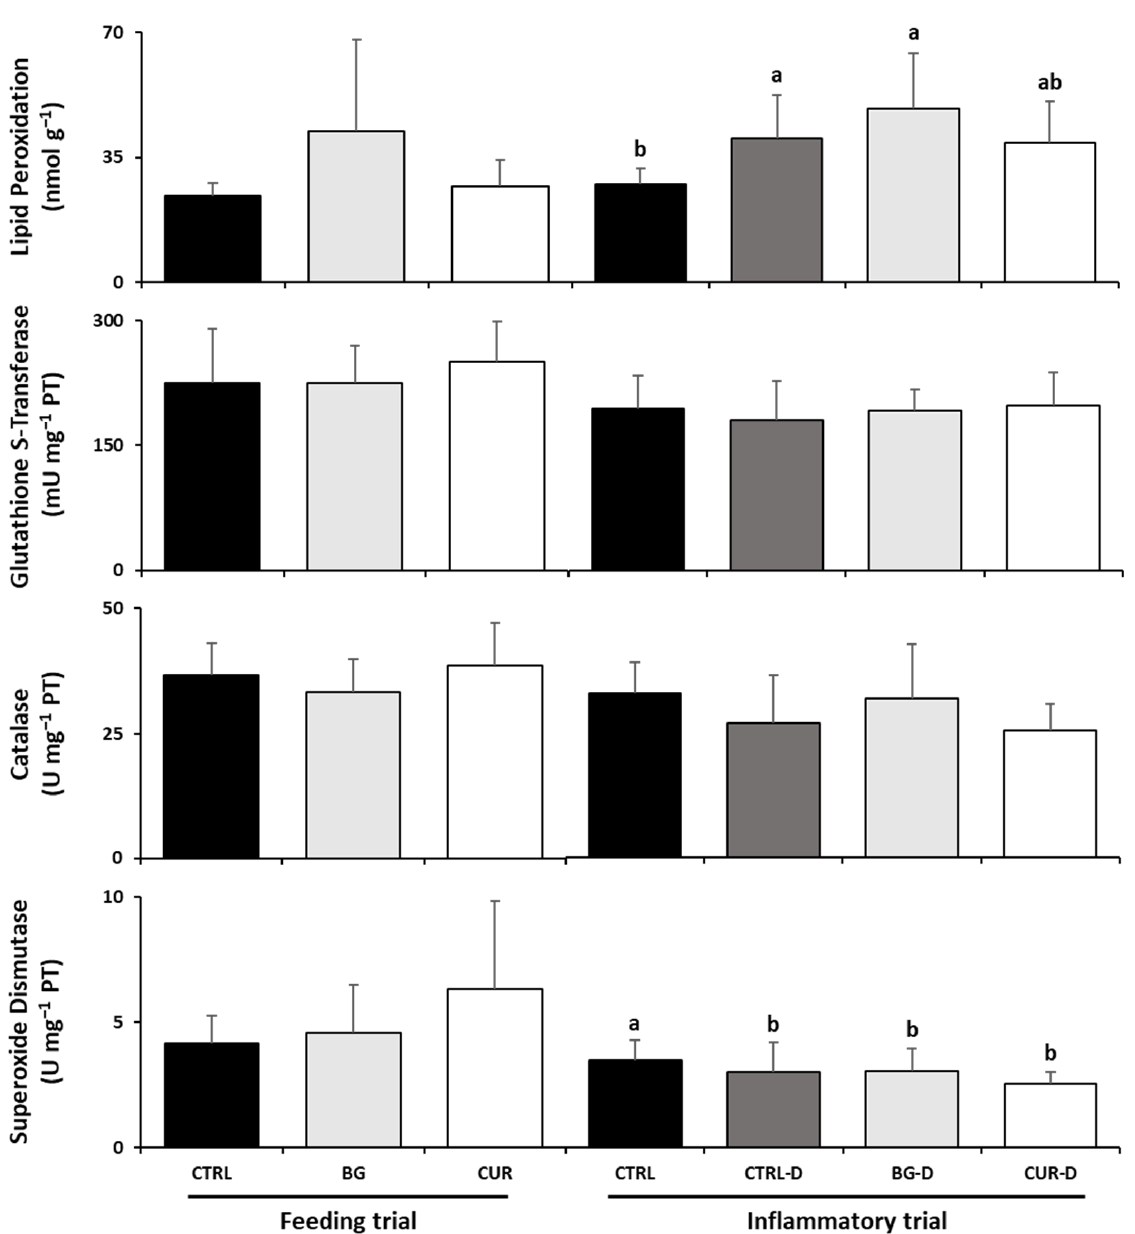
Figure 6. Intestinal oxidative stress biomarkers of gilthead seabream after the feeding and inflammatory trials ( n = 12). CTRL (control diet), BG ( β -glucans diet), CUR (curcumin diet), CTRL-D (control diet + dextran sodium sulphate − DSS), BG-D ( β -glucans diet + DSS), CUR-D (curcumin diet + DSS). Different letters mean significant differences among dietary treatments ( p < 0.05).